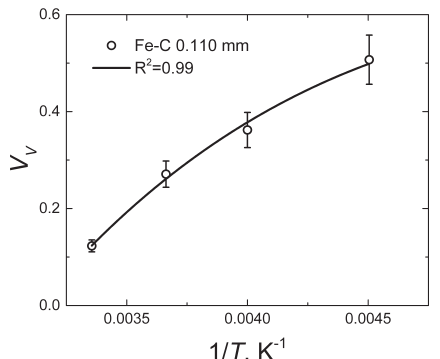
Fig. 9 – Volume fraction of martensite plates per unit of volume against transformation temperature. Fe-1.86wt%C alloy 30 with a mean intercept length of austenite grains equal to 0.110 mm. Solid line corresponds to the model developed here: equation 9. Error bars corresponding to an estimated relative error of ±10% were added to the plot.